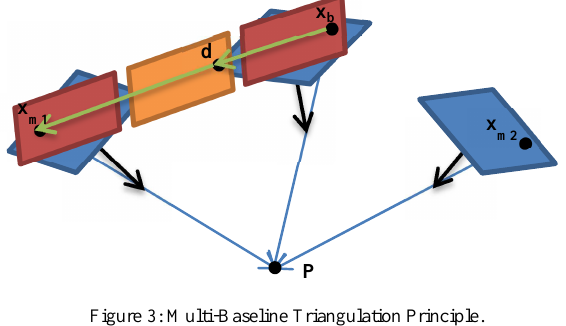
Figure 3: Multi-Baseline Triangulation Principle. One 3D point observed in 3 images (blue). Within a stereo model the correspondence is given by the disparity image (yellow), which is related to the epipolar images of the model (red).